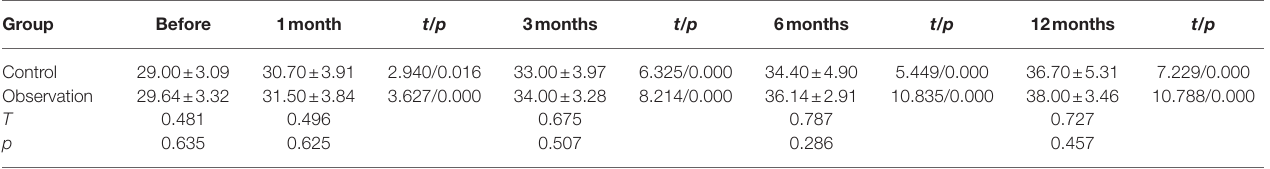
TABLE 2 | The serum ALB levels in the two groups before and after ABMI (mean ± SD, g/L). Group